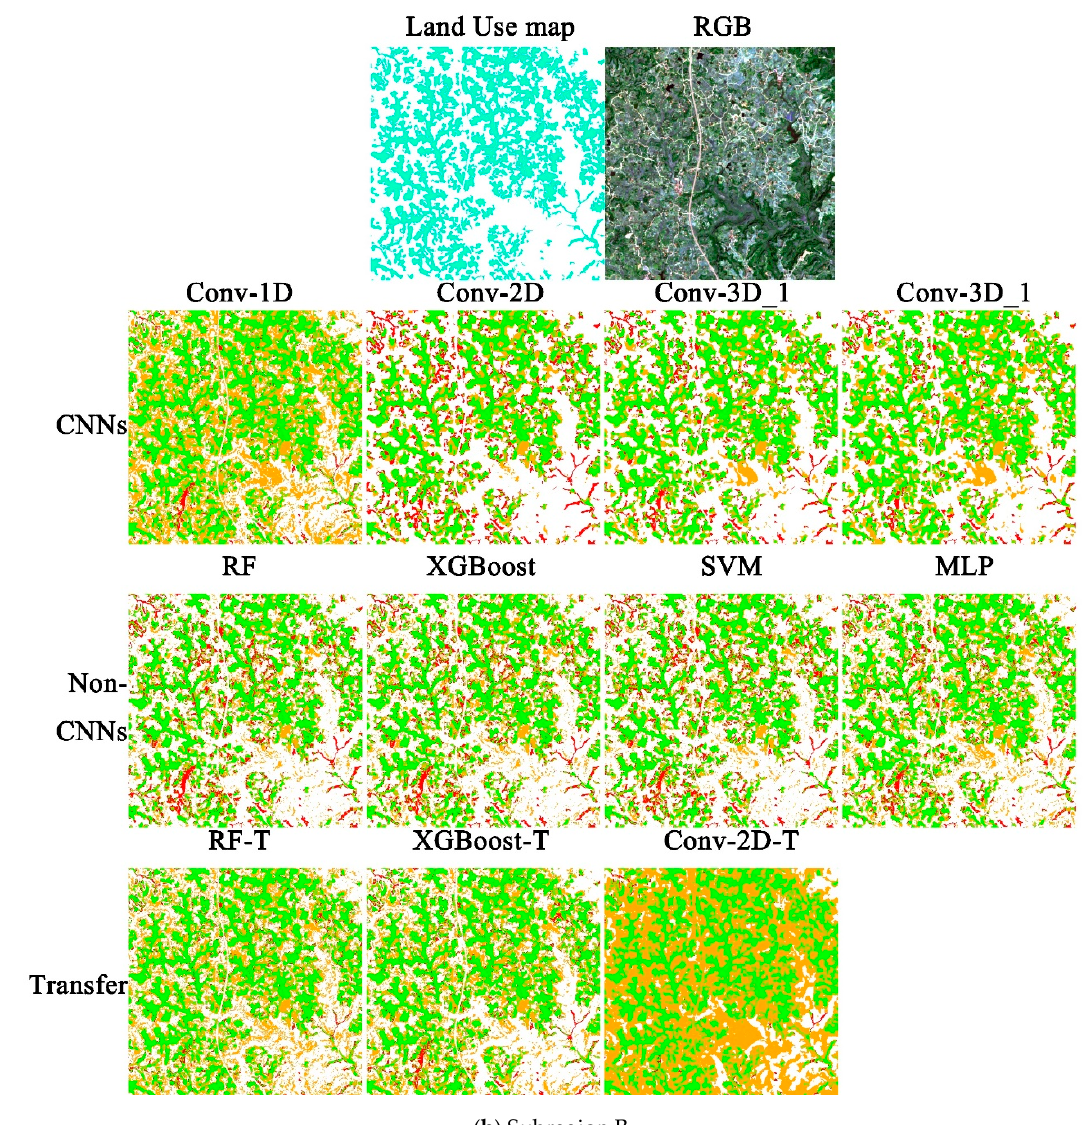
Figure 4. Subregion classification results (( a ) Subregion A in Banan District and ( b ) Subregion B in Zhongxian County) based on different methods, Land Use Map (cyan-blue pixels represent the referenced rice pixels) is land-use vector data in 2017 for comparison, RGB is Sentinel-2 true color composite image (green pixels represent the overlap between result maps and the reference map, and red pixels and yellow pixels represent under-classification pixels and over-classification pixels, respectively); transfer represents the transferable results of the relatively reasonable classifiers (refer to Section 4.2).